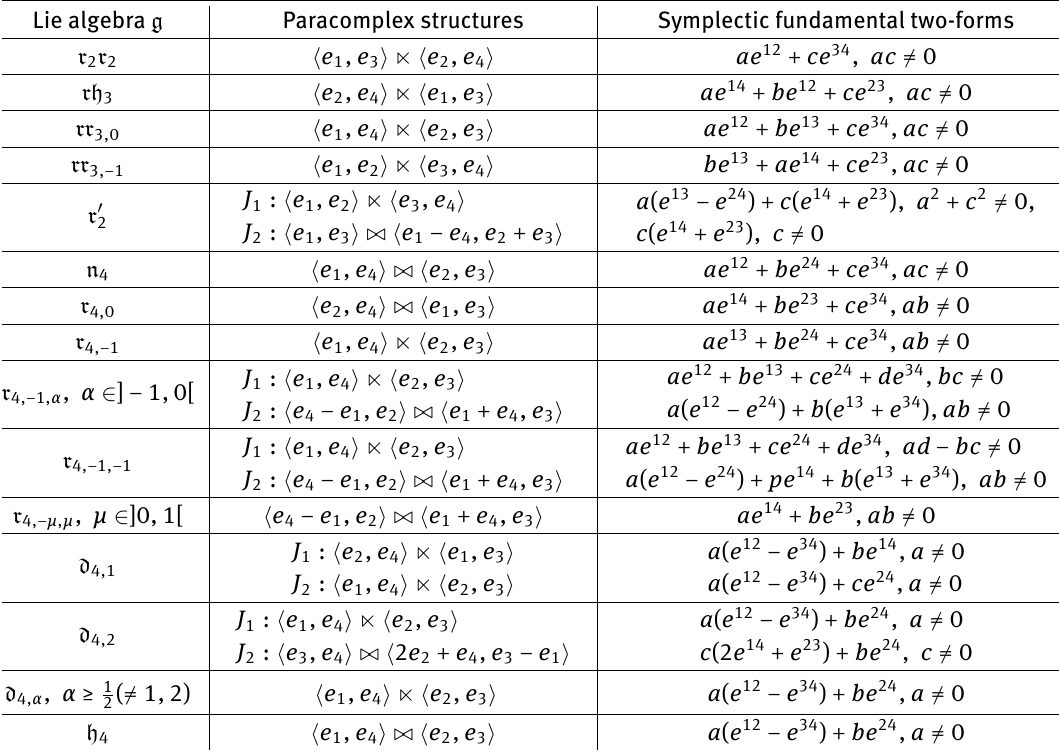
Table 3: Four-dimensional paraKähler Lie algebras. Lie algebra g Paracomplex structures Symplectic fundamental